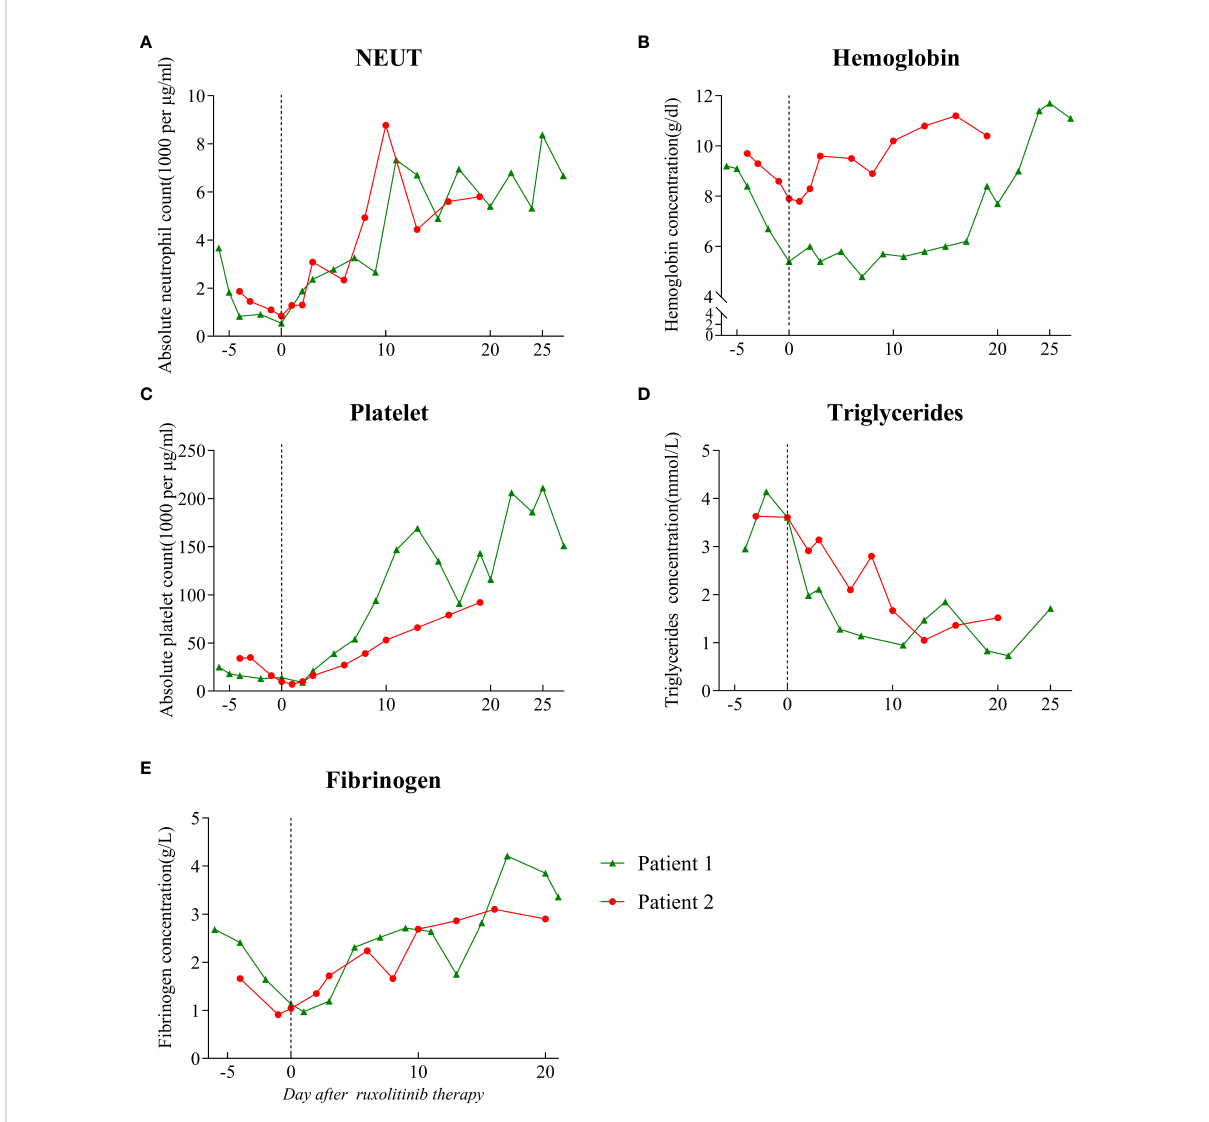
FIGURE 1 Hematological parameters prior to and following the start of ruxolitinib treatment. The dotted line on the graph indicates the day on which ruxolitinib treatment was started. (A) Absolute neutrophil count. (B) Hemoglobin level. (C) Absolute platelet count. (D) Triglyceride level. (E) Fibrinogen level. NEUT: